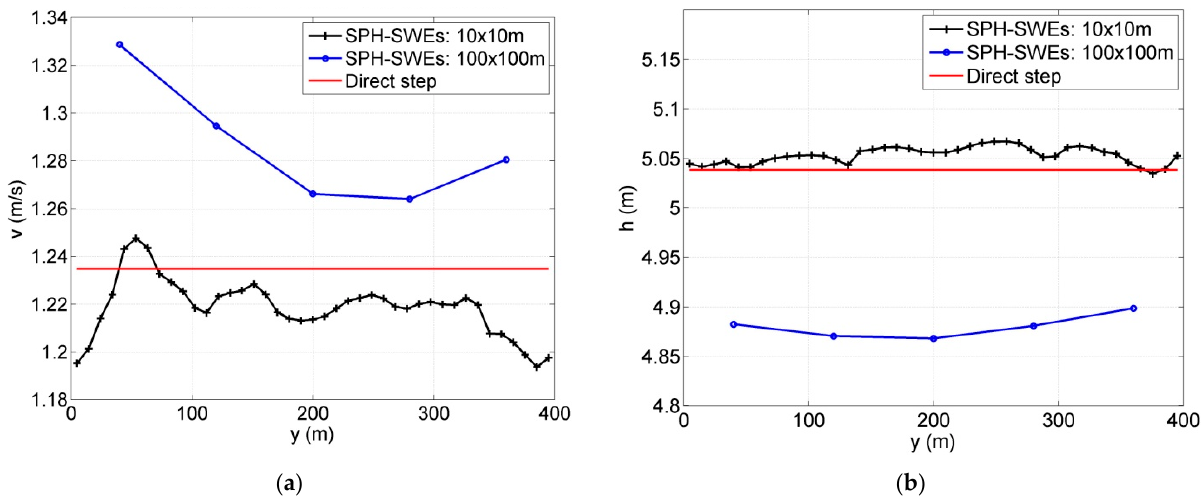
Figure 6. Results of 2D simulation for M1 curve cross-sectional view: ( a ) velocity and ( b ) water level.